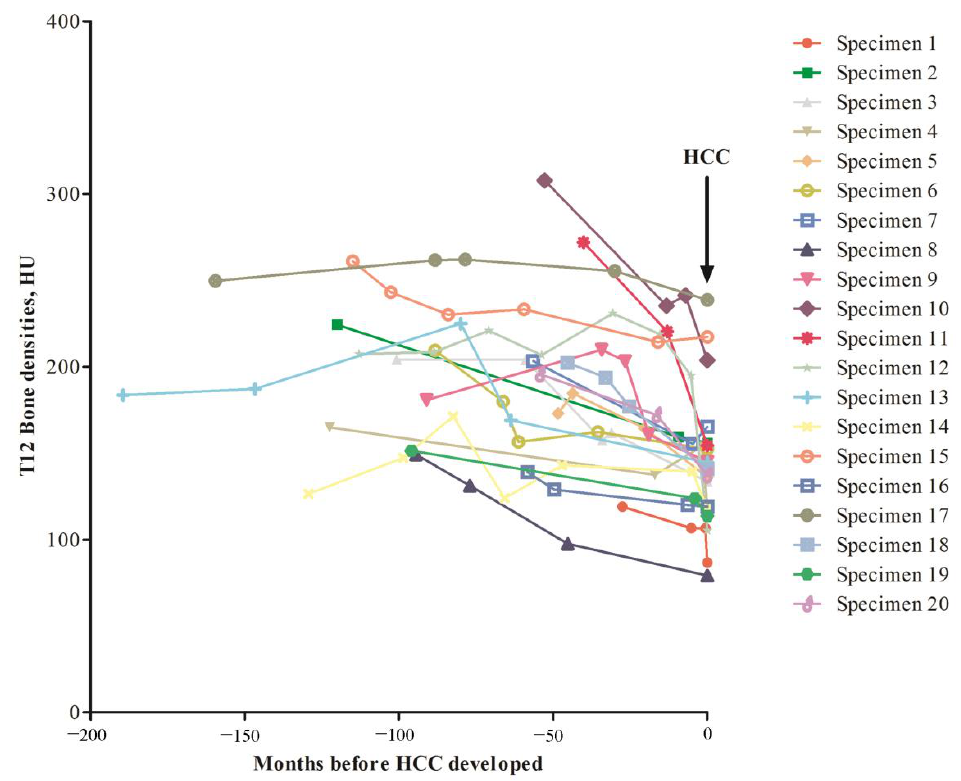
Figure 2. Retrospective examination of BD changes in serial CT images of 20 patients diagnosed as HCC. Arrow, time point when HCC was diagnosed. Vertical axis, T12 BD in HU unit; Horizontal axis, time period before HCC was diagnosed.